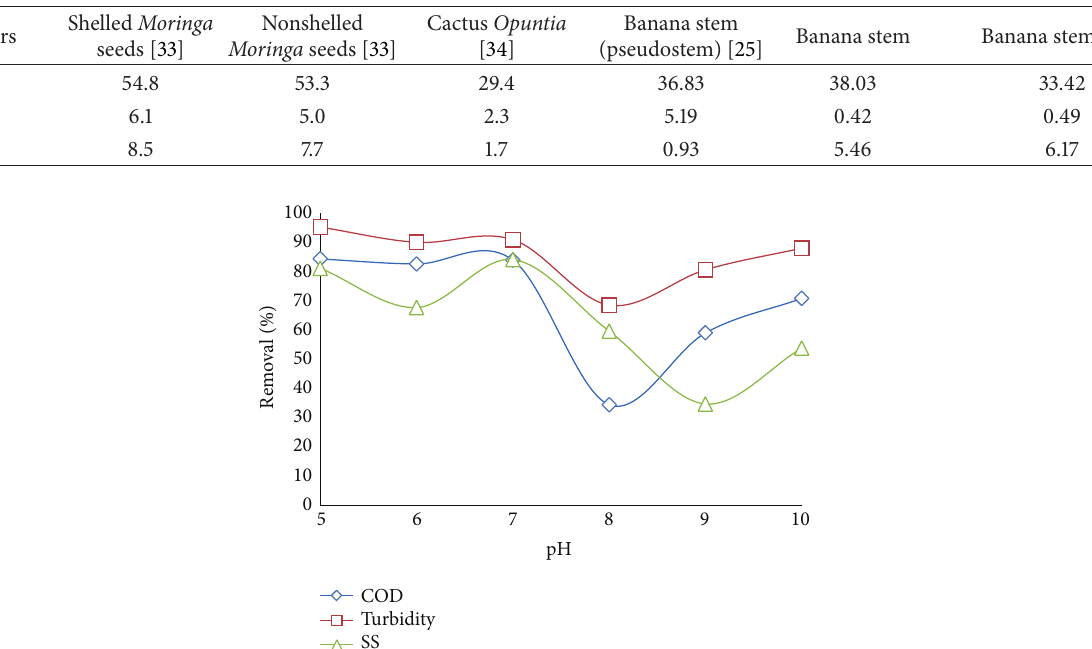
Table 3: Elemental analysis of banana stem, banana stem juice, and comparison with other natural coagulants.